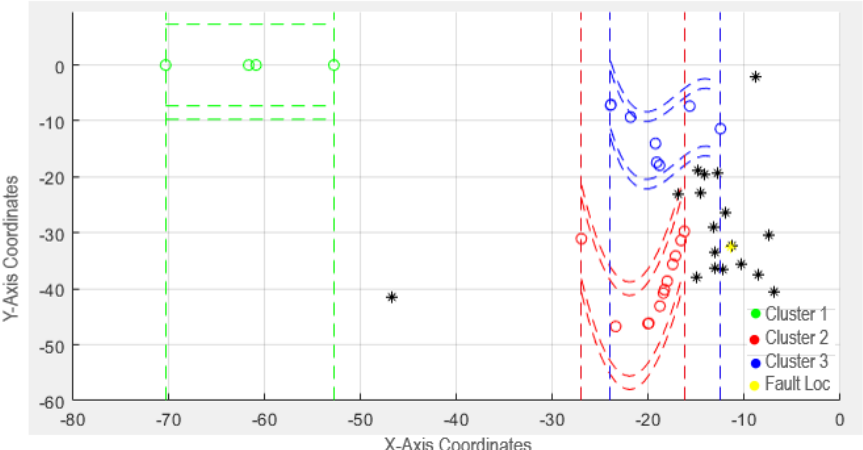
Figure 17. 1000 Ω fault identified.